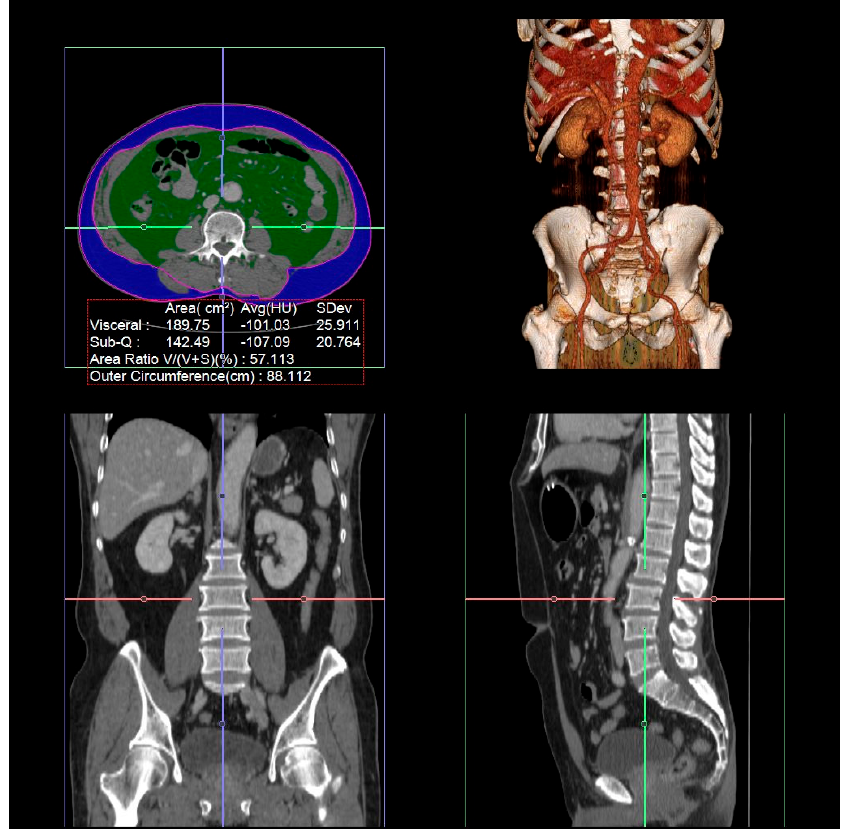
Figure 2. Example of body composition measurement at the level of the third lumbar vertebra on a computed tomography scan in the Hounsfield unit by AquariusNET Server.